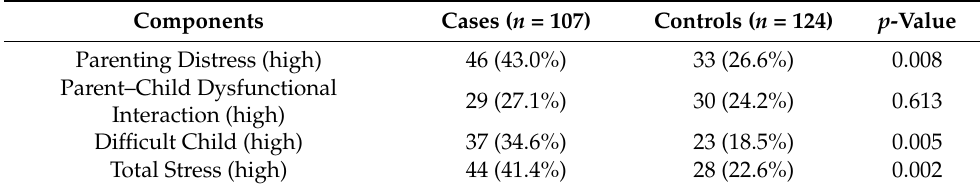
Table 4. Comparison of PSI-SF survey results between cases and controls.